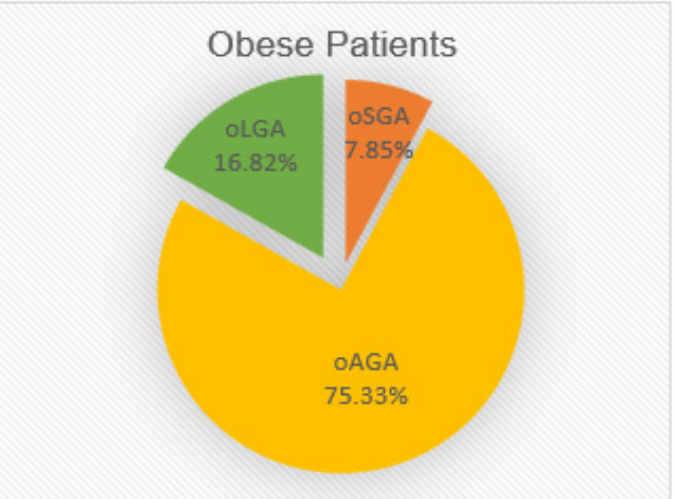
Figure 1. Percentage distribution of patients obese small for gestational age (oSGA), obese appro- priate for gestational age (oAGA), and obese large for gestational age (oLGA) included in the study according to birth weight (BW) for gestational age (GA)).